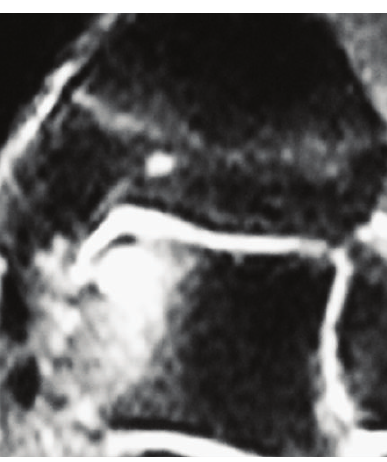
Figure 2: Coronal MRI view 2 years after the first operation. The cartilaginous layer was present, but it was submined by a subchondral cyst.